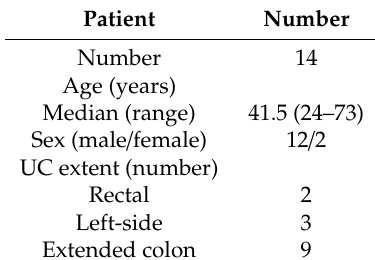
Table 1. Patient demographics for mRNA expression level measurement.